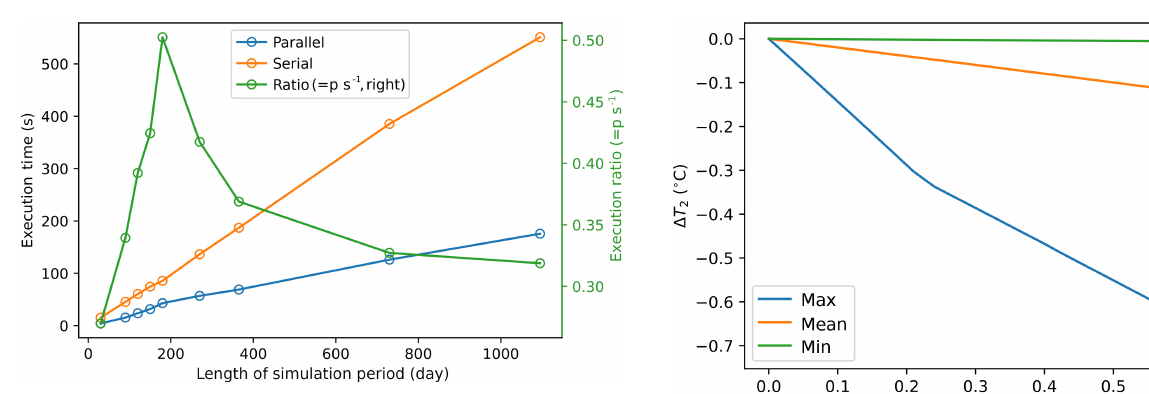
Figure 5. Impacts of increasing building roof albedo α (from 0.1) on near-surface temperature T 2 considering monthly maximum, mean and minimum temperatures at 2m for July 2012 based on 5min